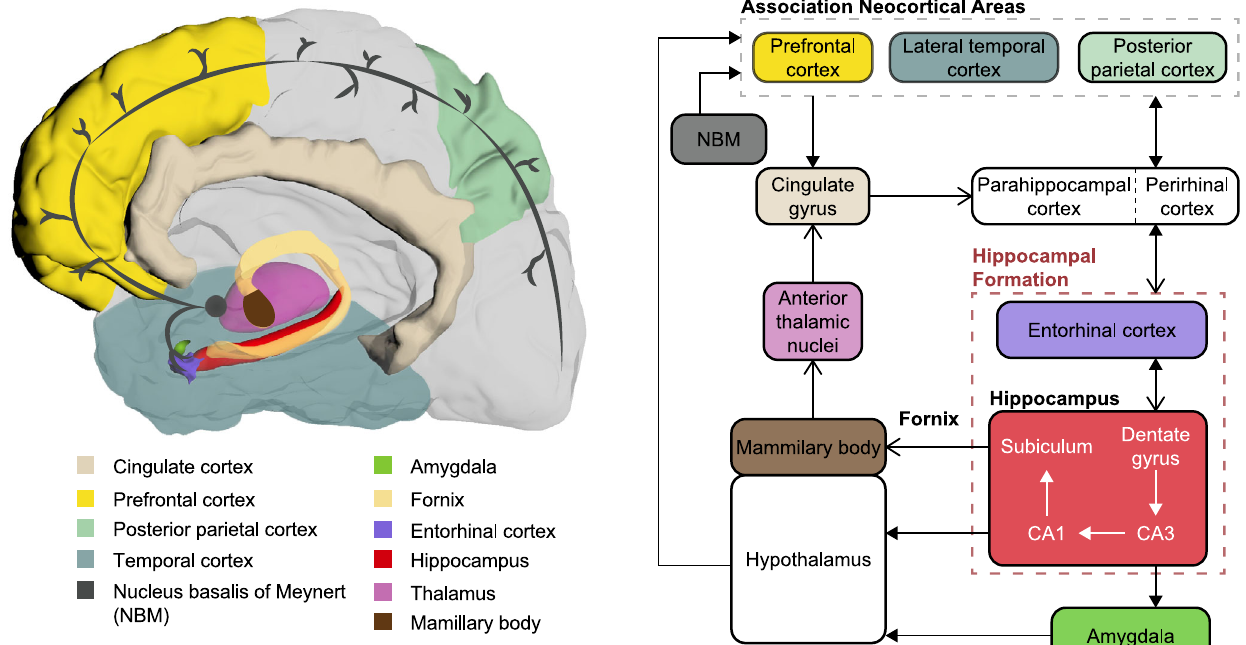
Fig. 3 Possible neuromodulation strategies for cognitive impairment and dementia. a Limbic and cortical structures involved in cognition, in particular episodic memory. These structures are part of a common large-scale brain network. b Schematic representation of the connections between these structures, including intra-hippocampal circuitry (red dashed box), the original circuit of Papez (open arrowheads), and additional connections between them ( fi lled arrowheads). The NBM provides widespread cholinergic innervation to neocortical areas and has therefore received attention as a neuromodulation target for cognition. The fornix has been the main chronic DBS target in AD patients. Other areas (hippocampus, EC, neocortical areas) have been mainly targeted in acute studies in epileptic